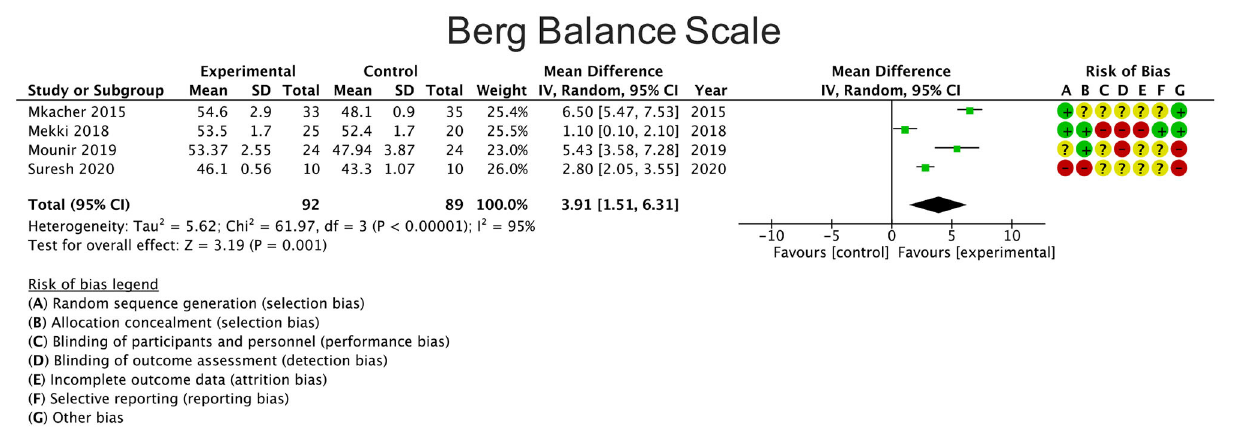
FIGURE 2 | Effects of rehabilitation interventions on the Berg balance scale. Each study considered in the meta-analysis corresponds to a point estimate, which is bounded by a 95% CI.